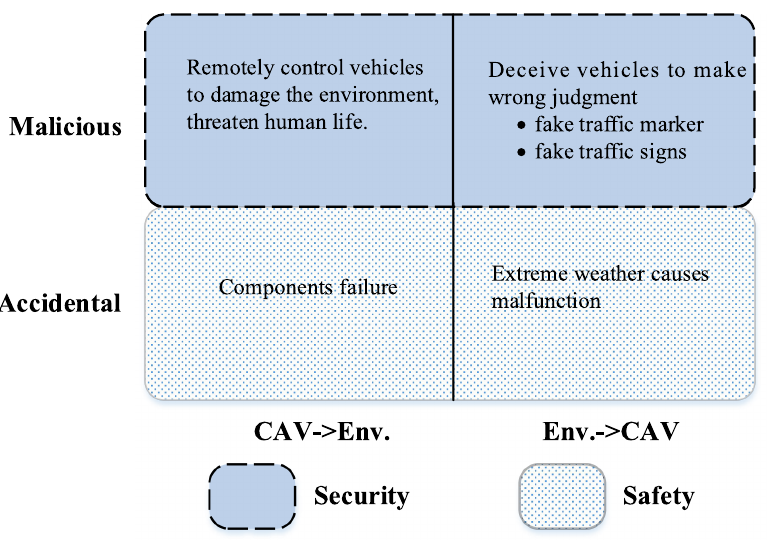
Figure 1. Safety vs. security in